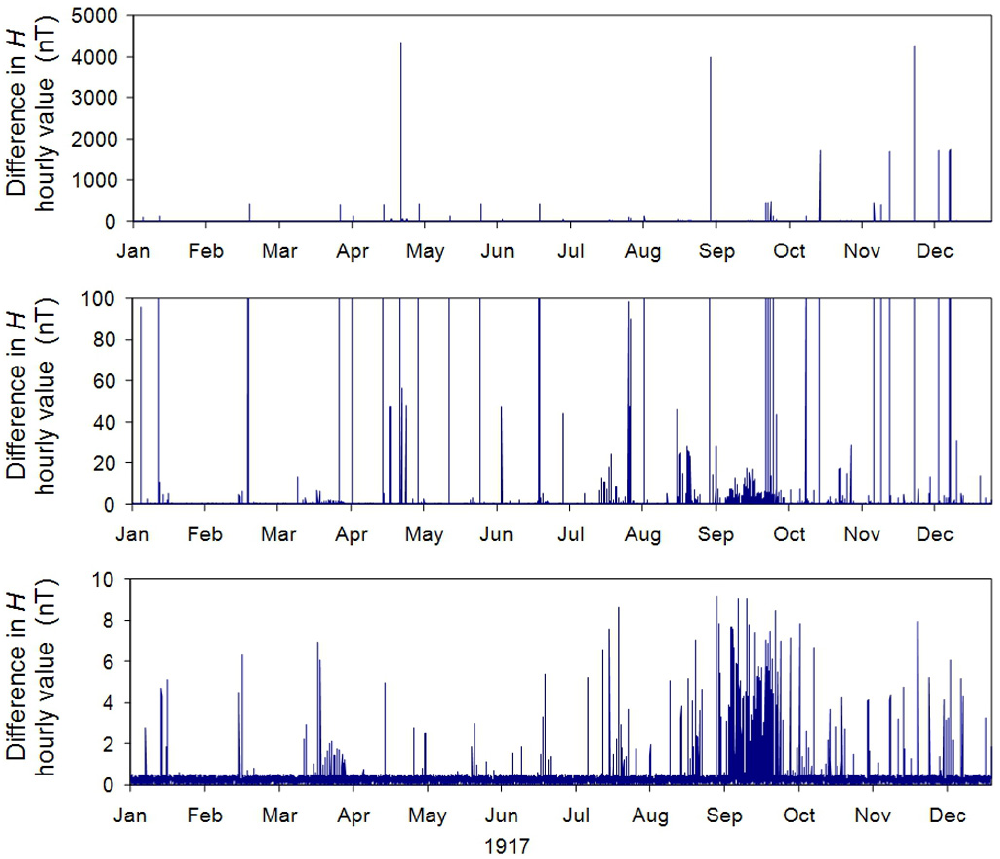
Fig. 3. Errors in the hourly mean values for 1917 from manual data entry carried out in 2007. The top panel shows full range of errors, the middle panel reduces the range to 100nT to show more detail and the bottom panel shows the remaining errors following the corrections described in the text.